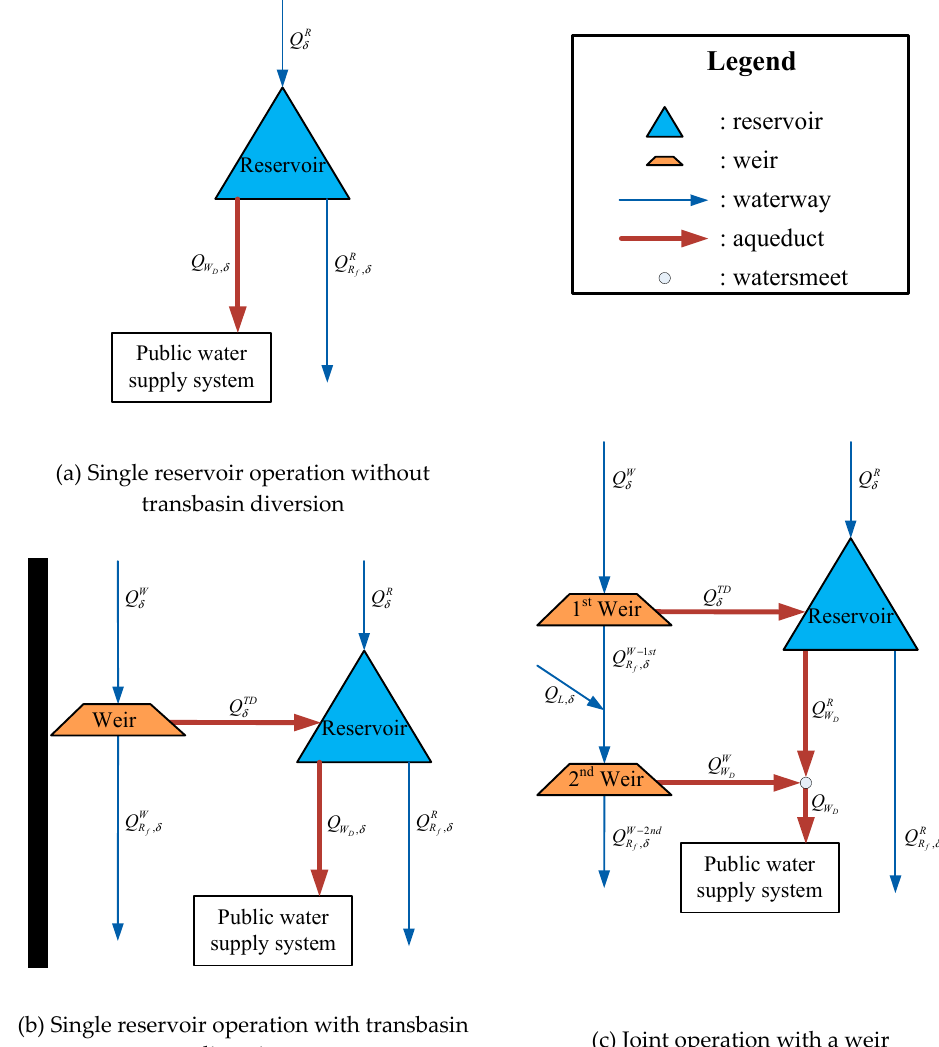
Figure 4. The operation rule of single reservoir and joint operation.